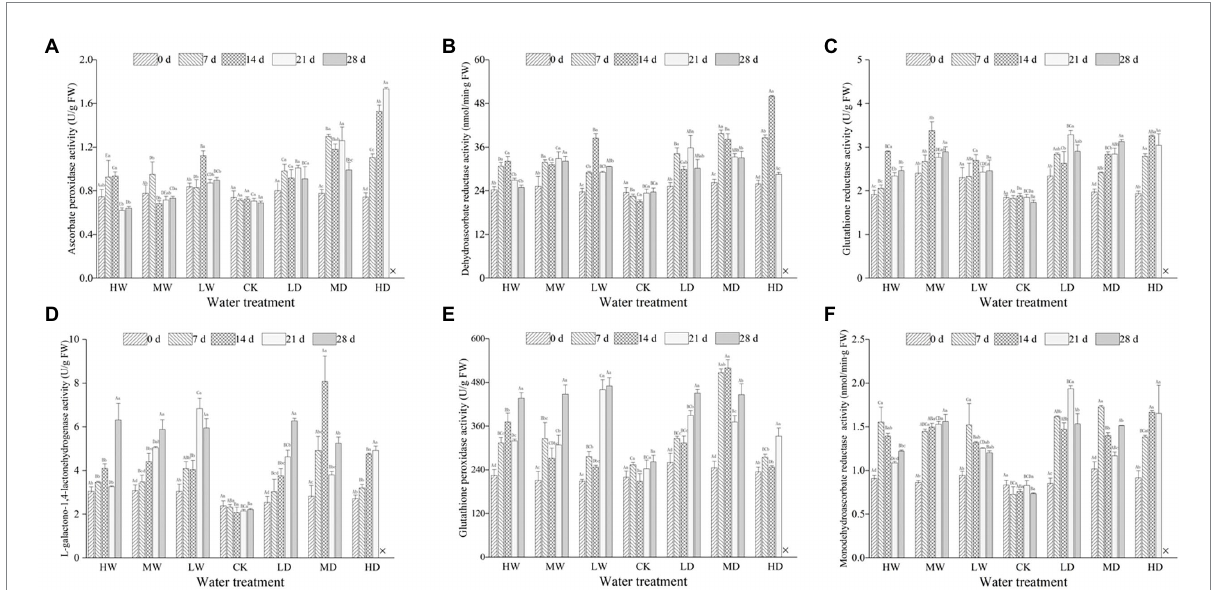
FIGURE 3 Enzymatic activities of ascorbate peroxidase (A) , dehydroascorbate reductase (B) , glutathione reductase (C) , L-galactono-1, 4-lactone dehydrogenase (D) , glutathione peroxidase (E) and monodehydroascorbate reductase (F) in leaves of hairgrass ( Deschampsia caespitosa ) under different hydrological regimes. Bar values are the mean ± standard error ( N = 3). Different lowercase letters indicate that there are significant differences among stress exposure durations under the same hydrological treatment; and different capital letters indicate that there are significant differences across different water hydrological regimes at the same exposure duration. X represents the plant died, and thus not allows this parameter to be determined unless stated otherwise. Water treatment are as follows: HW, Heavily waterlogging; MW, Moderate waterlogging; LW, Light waterlogging; CK, Control; LW, Light drought; MW, Moderate drought; and HW, Heavily